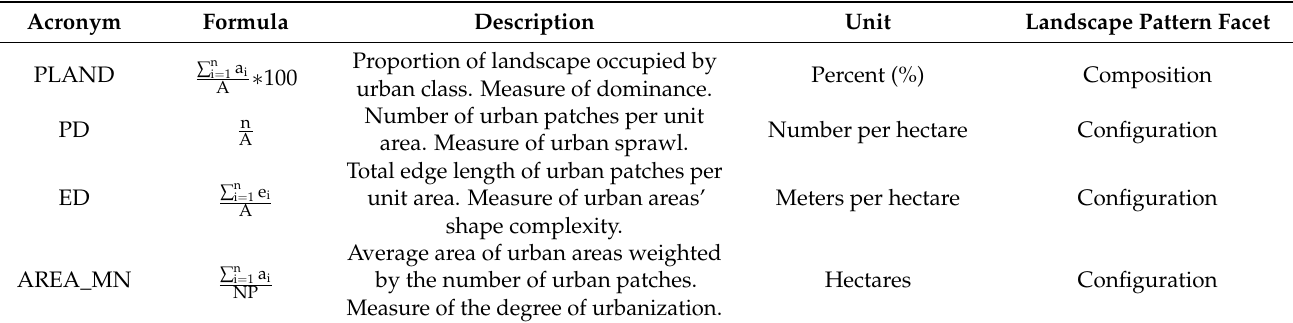
Table 1. Computed landscape parameters reporting the relative acronym, formula, description, unit of measure and landscape pattern facet. PLAND = urban area, NP = number of urban patches, PD = urban patches’ density, ED = urban edges’ density, AREA_MN = mean urban patch area.